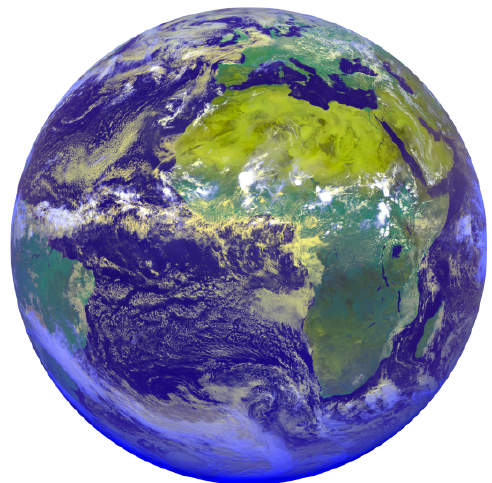
Figure 2. Overview red-green-blue composite of MSG/SEVIRI measurements for 15 July 2015 at 12:00